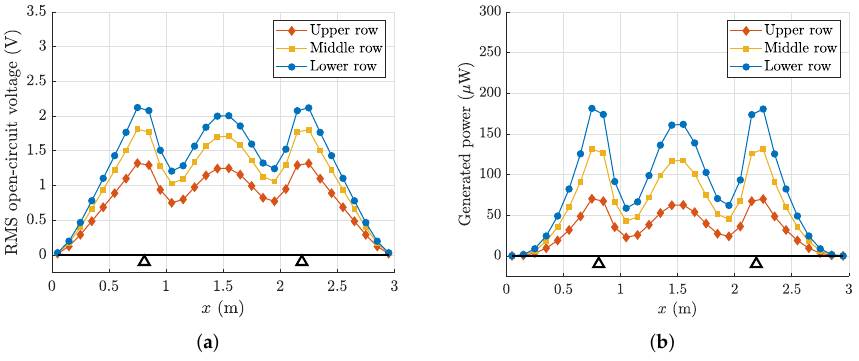
Figure 11. Grid of test positions.